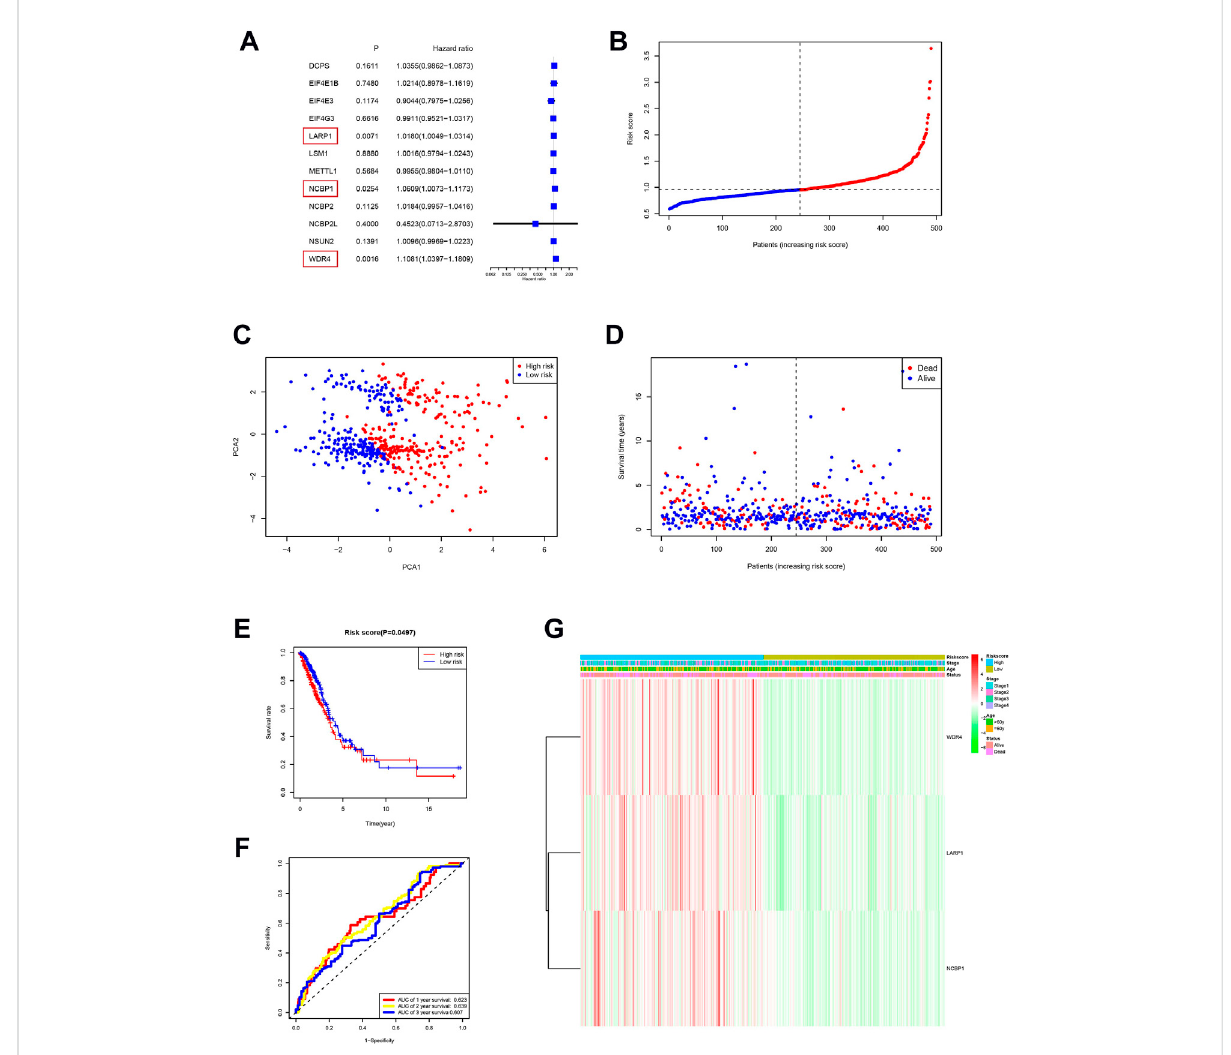
FIGURE 4 RisksignatureestablishmentoftheTCGAqueue. (A) Single-variableCoxregressionstudyof12m7Gmethylation – relatedDEGsandthreegenes with p < 0.05. (B) Patientdistributiononthebasisofriskscore. (C) PCAdiagramofLUADsonthebasisofriskscore. (D) Livingsituationofeverypatient (low-risk population: left dotted line; high-risk groups: right dotted line). (E) Kaplan – Meier survival analysis for patients with high- and low-risk groups. (F) ROC pro fi le showing the forecasting power of risk scores. (G) The relationship among clinicopathological characteristics and risk groups is visualized with heatmaps (green: low expression; red: high